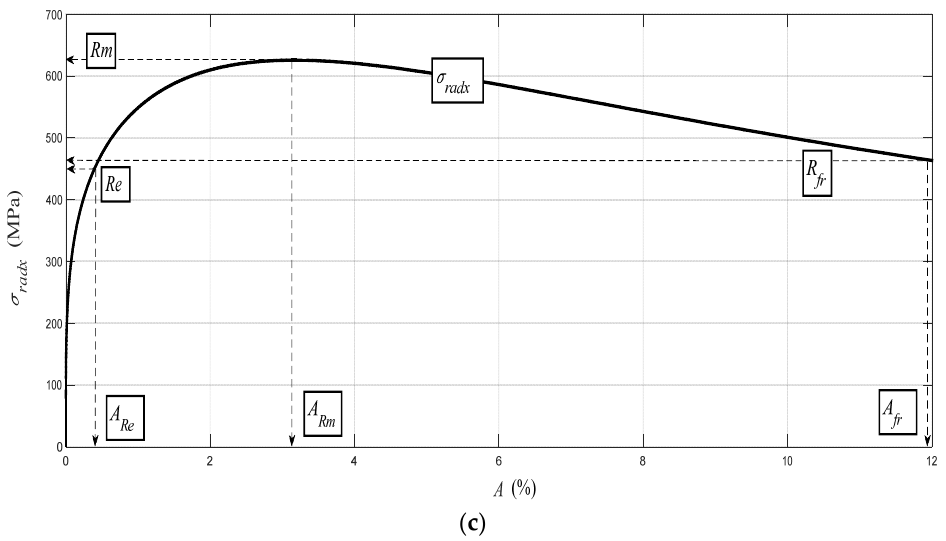
Figure 3. ( a ) Deformational diagram from the tensile test for the steel grade S355J0 for the dependence σ def = f ( A ); ( b ) Comparison of results ( σ rzxE , σ defM , σ radx ) = f ( A ) for the steel grade S355J0; Stresses σ rzxE and σ radx were derived analytically, and σ defM is obtained from the tensile test; ( c ) Analytical deformational diagram for the steel grade S355J0 for the dependence σ radx = f ( A ); comparing diagram.